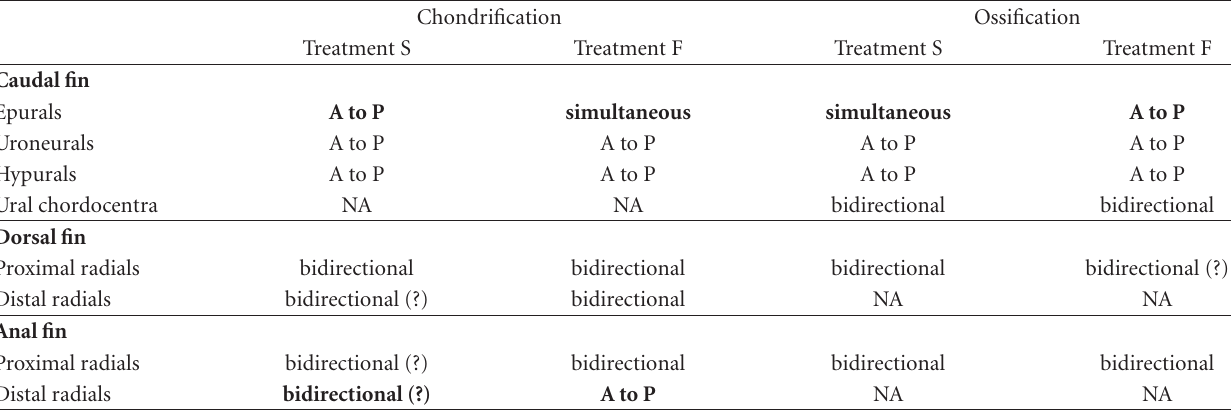
Table 3: Direction of chondrification and ossification for the serially repeated elements of the median fins of Salvelinus alpinus reared under two treatments of water velocity (treatments S and F). Three conditions of direction have been interpreted: antero-posterior (A to P), bidirectional, and simultaneous (all elements forming simultaneously). (?) refers to ambiguous directionality (see text). NA is for not applicable. Bold-face indicates di ff erence between